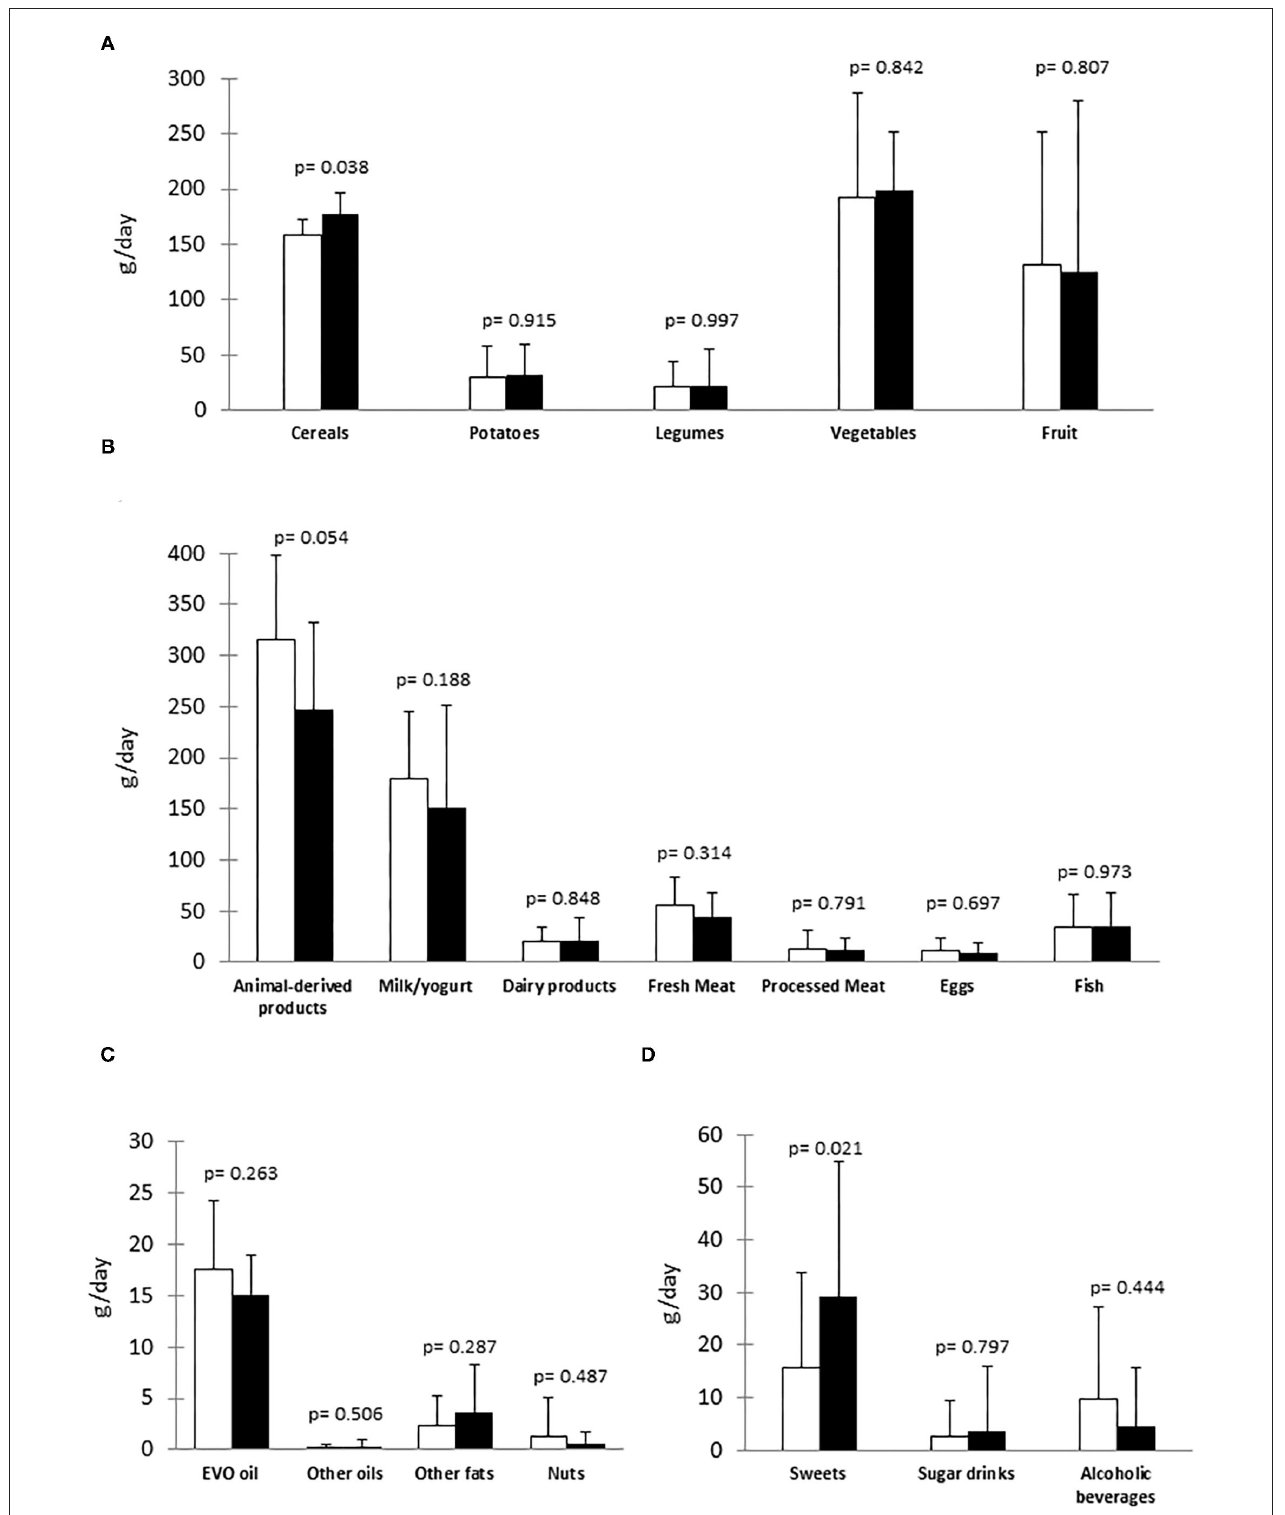
FIGURE 1 | Food groups consumption before lockdown (White column) and during lockdown (Black column) in the type 1 diabetes (T1D) study participants ( n = 12). (A) Main sources of carbohydrate/fiber; (B) Main sources of protein; (C) Main sources of fat; (D) Other food and beverages. EVO oil, extra-virgin olive oil.